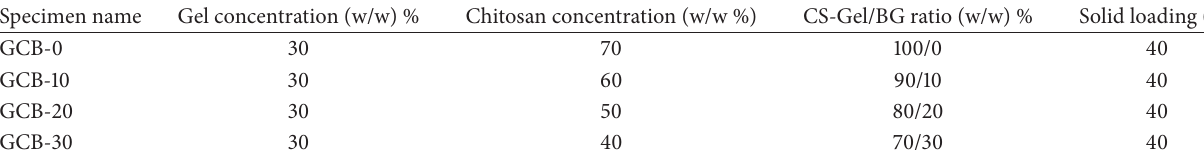
Figure 2: FTIR and XRD pattern of 58S bioglass powder prepared via sol-gel process. Table 1: Component of prepared scaffolds.